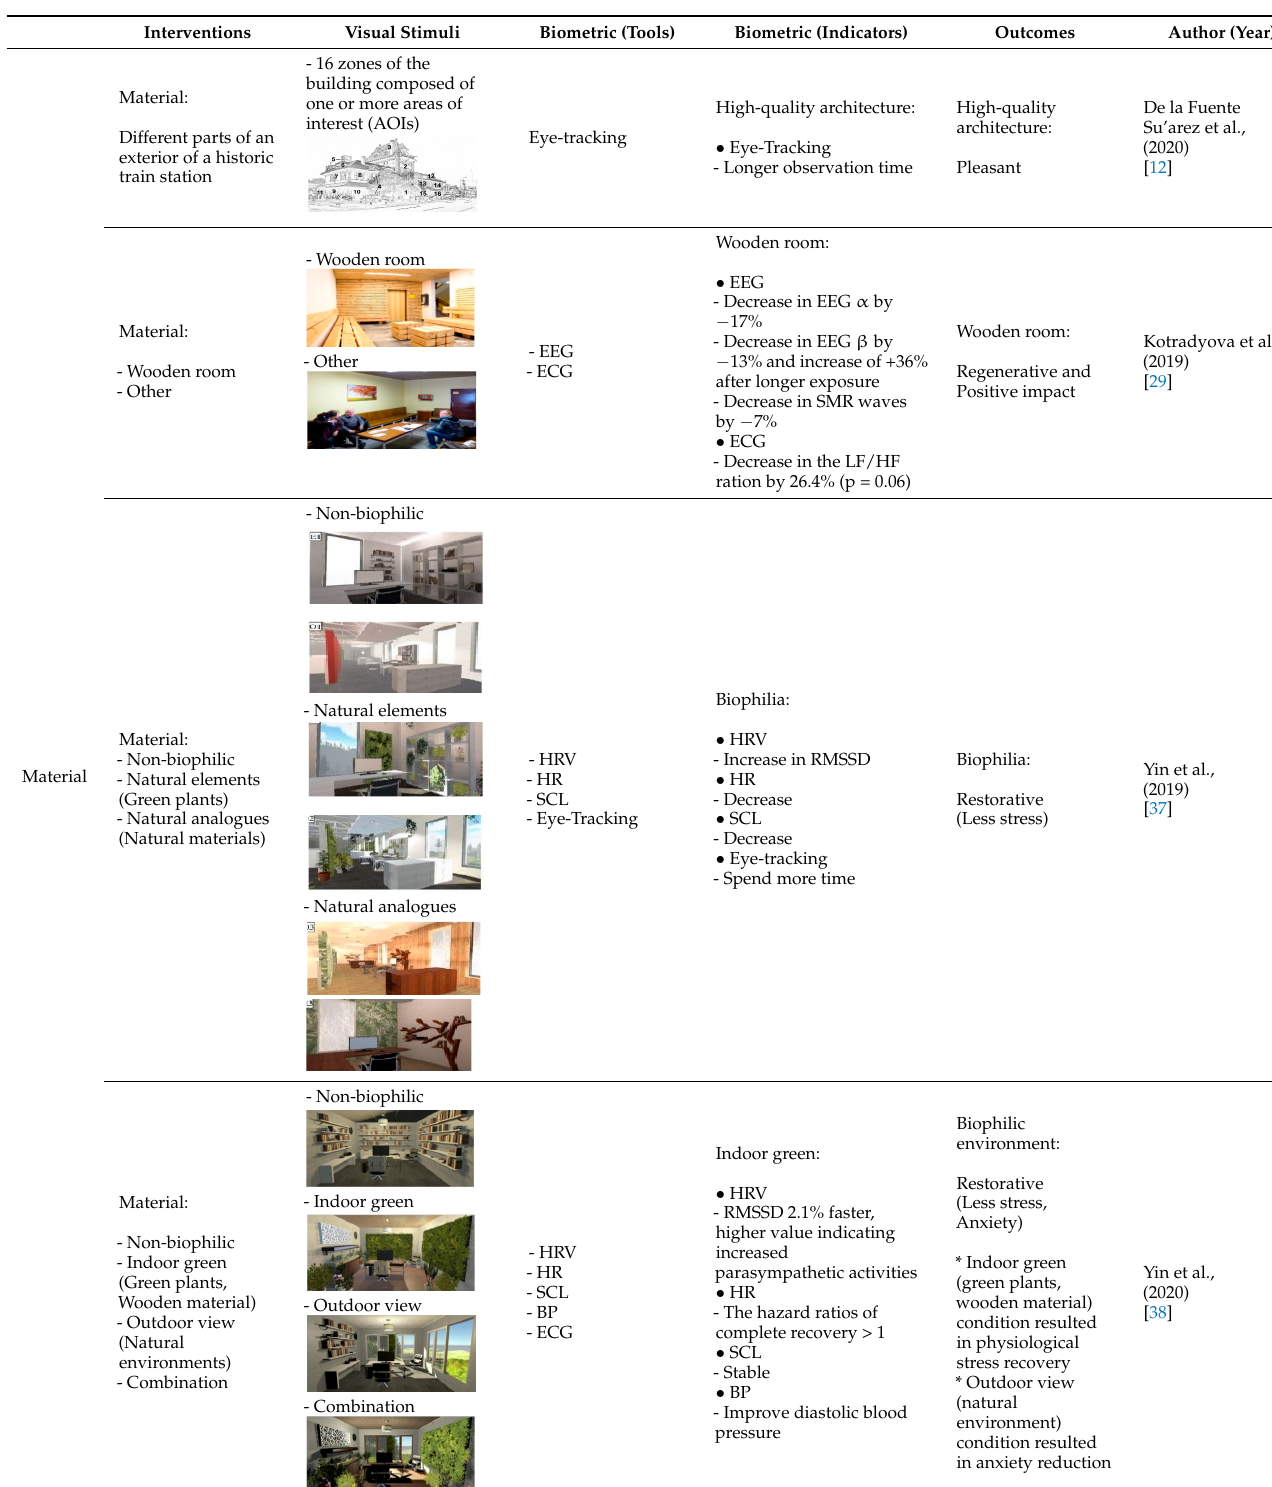
Al-Ayash Al-Ayash Al-Ayash et al., et al., et al., (2016) (2016) (2016) [24] [24] [24]